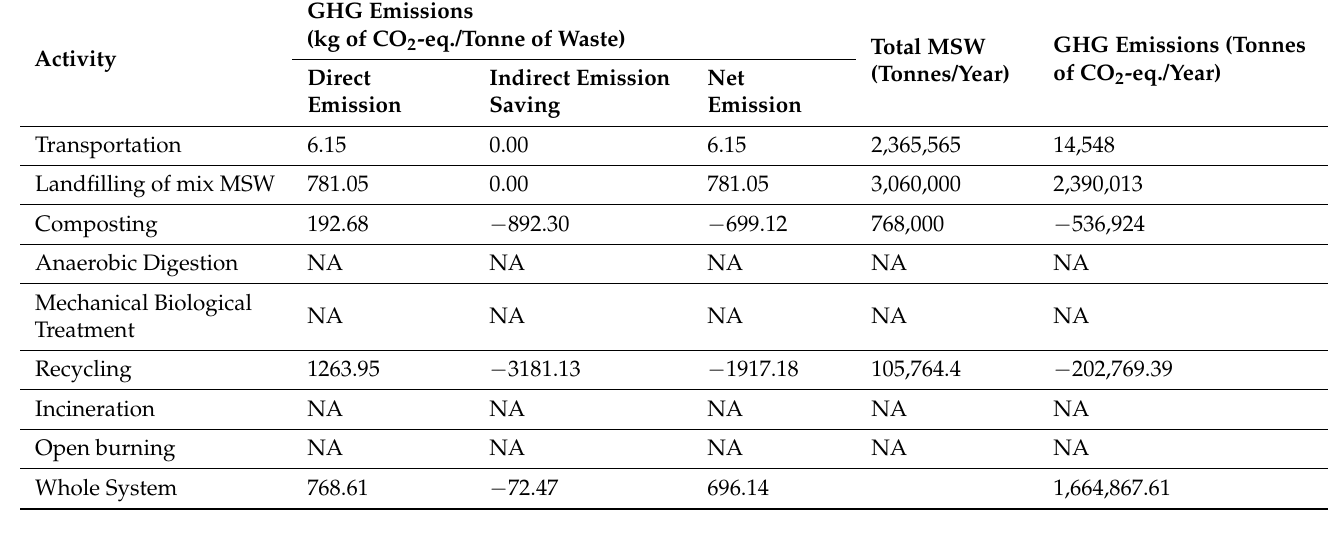
Table 6. Summary of estimates of GHG emissions from various solid waste mismanagement activities in Ho Chi Minh City including the whole solid waste management system.